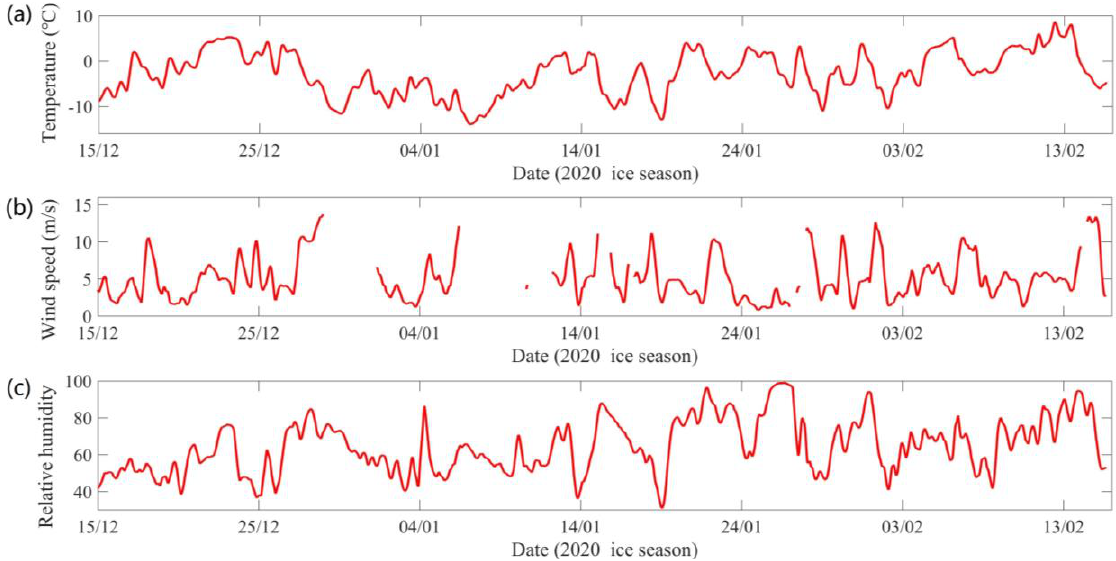
Figure 3. Time series (2020/2021) of ( a ) hourly measured air temperature, ( b ) hourly measured wind speed, ( c ) hourly measured humidity.